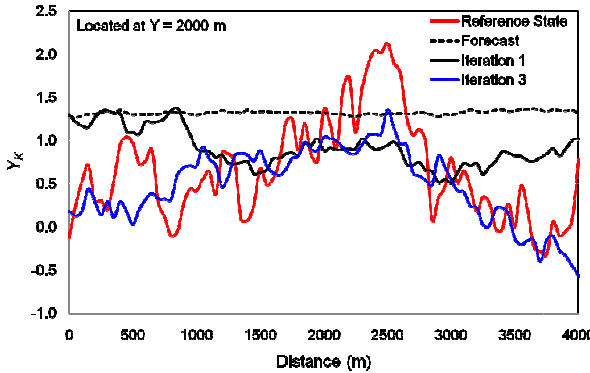
Figure 16. Value of Y K along the Y = 2000 m transect for the reference state (red), the foreacast 2 along the Y = 2000 m transect for the reference state (red), the foreacast along the Y = 2000 m transect for the reference state (red), the foreacast ensemble mean Fig. 16. Value of Y K along the Y = 2000 m transect for the ref- (dotted black line) and the update ensemble mean for the 1 3 (dotted black line) and the update ensemble mean for the 1 st (solid black line) and 2 nd (solid blue line) iteration, (solid blue line) iteration, erence state (red), the foreacast ensemble mean (dotted black line) 4 for the case where the true values of m and s 2 are 0.301 log m day -1 and 0.500 (log m day -1 ) 2 , respectively. , respectively. and the update ensemble mean for the 1st (solid black line) and 2nd K Y K Y K Y (solid blue line) iteration, for the case where the true values of and are 0.301 log m day − 1 and 0.500 (log m day − 1 ) 2 ,